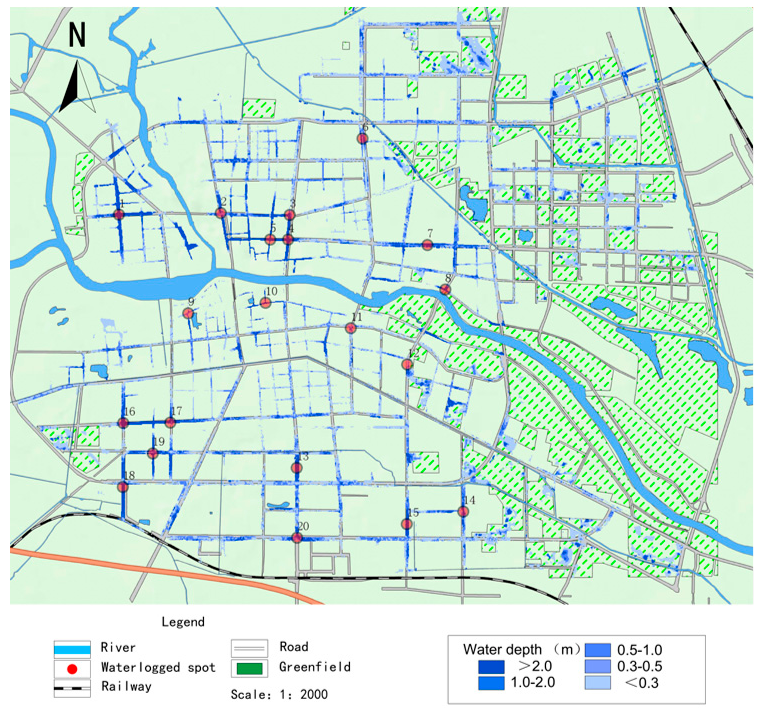
Figure 4. Distribution of major waterlogged sites on 2021.7.20.